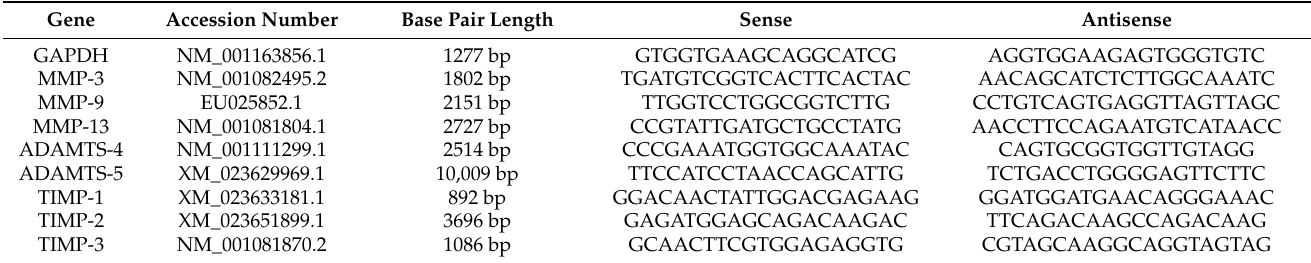
Table 1. Oligonucleotide Sequences of Specific Equine GOI Primers for RT-PCR.